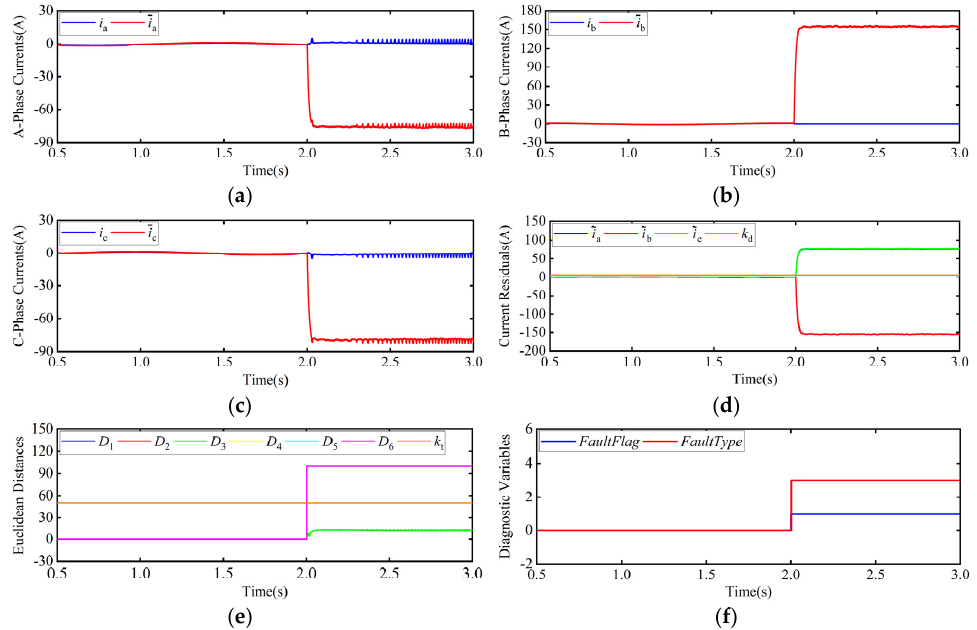
Figure 6. Diagnosis for the OC fault of T 3 under 1 N · m load and for a reference speed of 10 r / min: ( a ) A-phase currents; ( b ) B-phase currents; ( c ) C-phase currents; ( d ) current residuals; ( e ) Euclidean distances; ( f ) diagnostic variables.